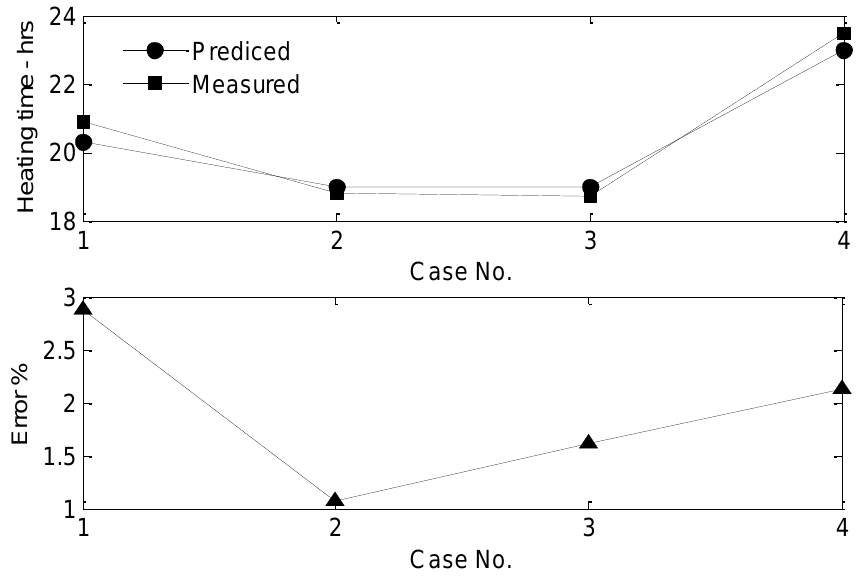
Figure 10. Illustration of the heating time prediction errors.